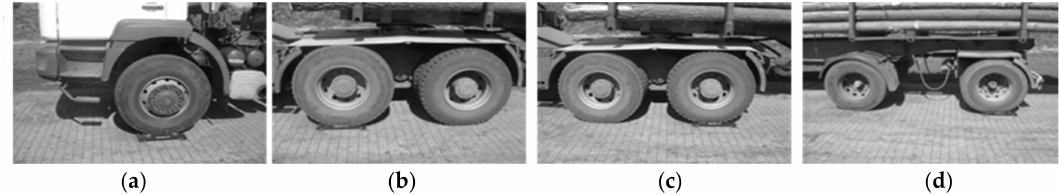
Figure 1. Stages of weighing the wheel axles of a truck unit hauling timber: ( a ) front axle, ( b ) second axle of the truck, ( c ) third axle of the truck, ( d ) rear axle.